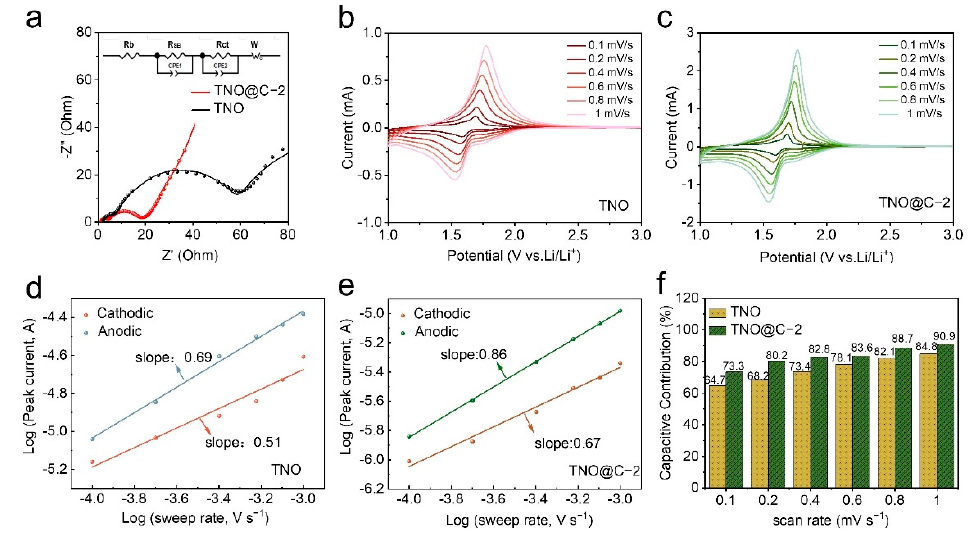
Figure 6 . ( a ) Nyquist plots of TNO and TNO@C-2; ( b ) electrical conductivity of the TNO and TNO@C-2; CV curves of ( c ) TNO and ( d ) TNO@C-2 at various scan rates; ( e ) the corresponding log ( i ) versus log ( v ) plots of TNO and TNO@C-2; ( f ) capacitive contribution ratios at different scan rates.